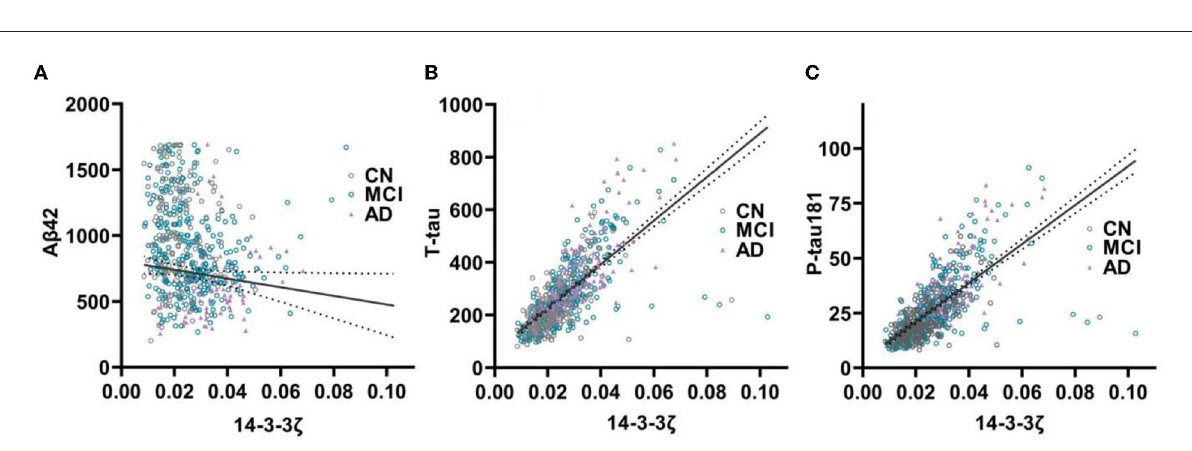
FIGURE3 The 14-3-3 ζ in relation to core biomarkers in CSF. The 14-3-3 ζ related to A β 42 (A) , t-tau (B) , and p-tau 181 (C)